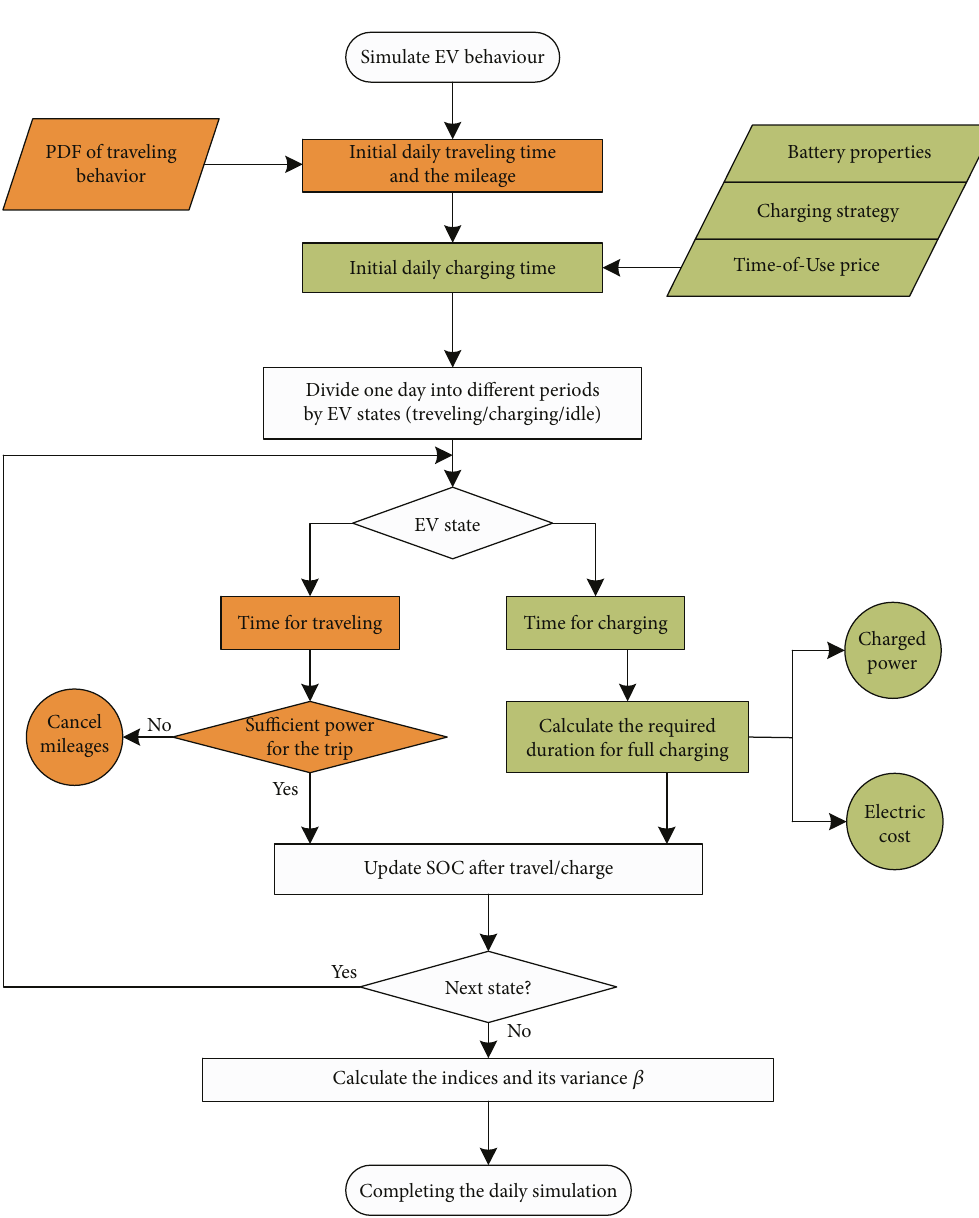
Figure 6: The MC simulation of the EV driving and charging behaviour per Table 4: The EV daily charging load index prediction in 2020 (unit: MW ).